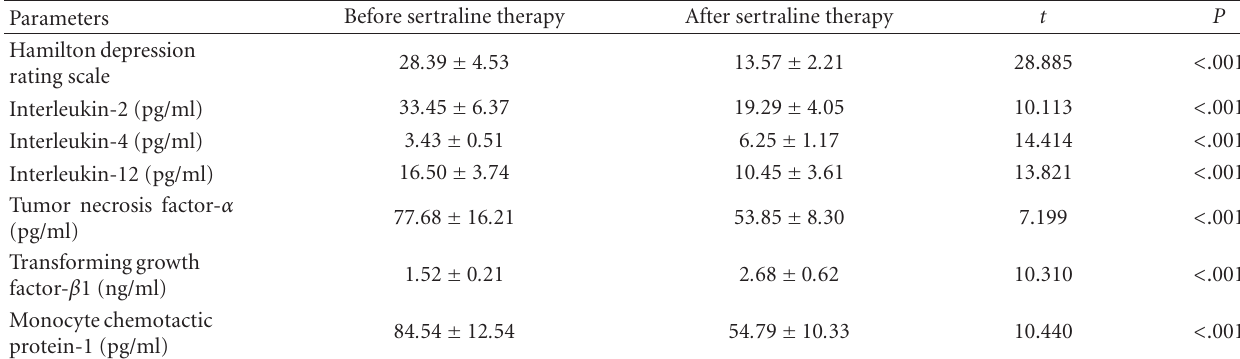
Table 2: E ff ect of sertraline therapy on clinical and immunological features in patient with major depression.